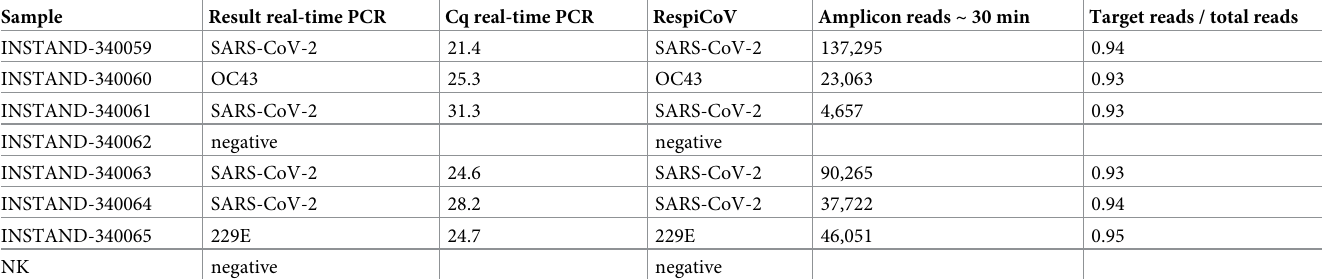
Table 4. Results of RespiCoV and specific real-time PCRs of the INSTAND exercise for quality assurance for SARS-CoV-2 diagnostics.